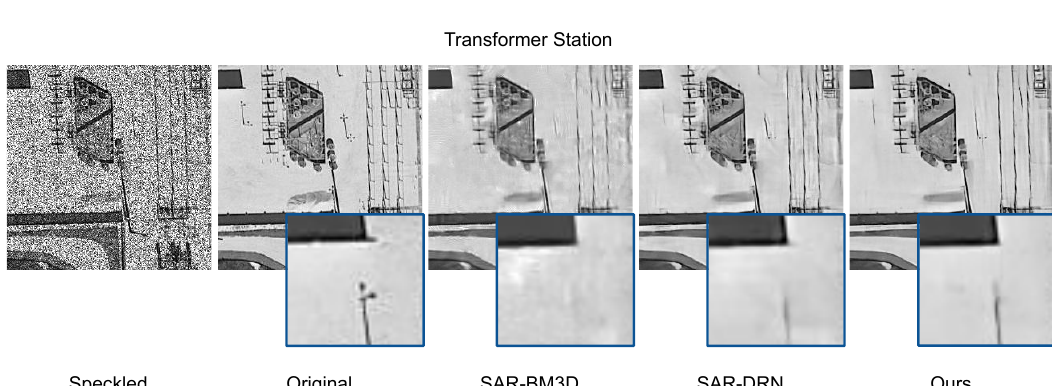
Figure 6. Qualitative results on Basketball Court, Bridge , Christmass Tree Farm and Transformer Station single look images from the test